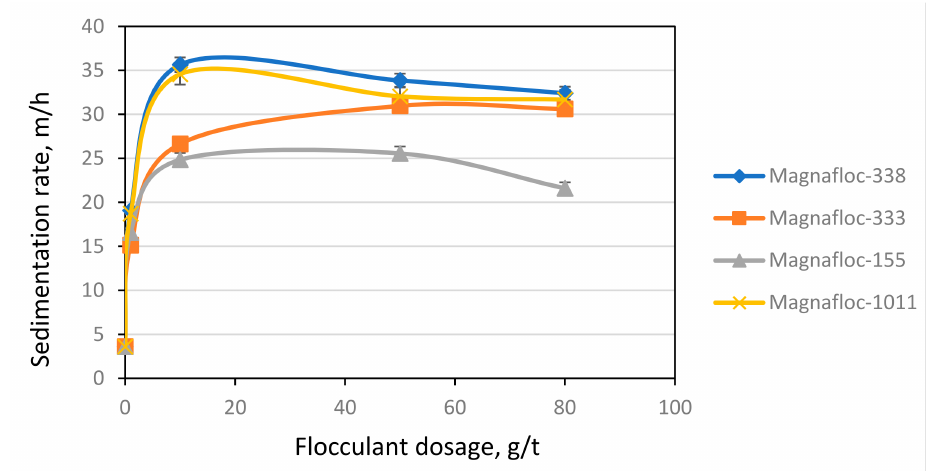
Figure 3. Sedimentation rate for different flocculants.